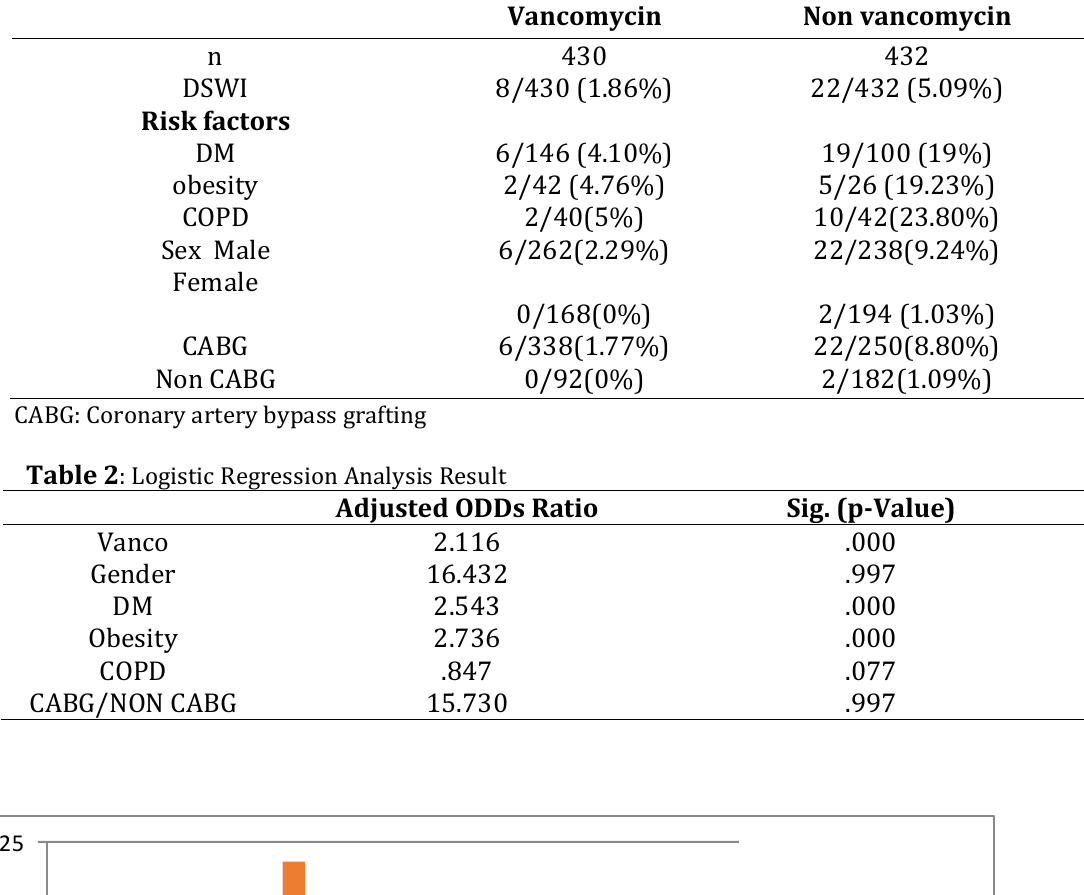
Table 1 : Risk factors and frequency of DSWI associated with them